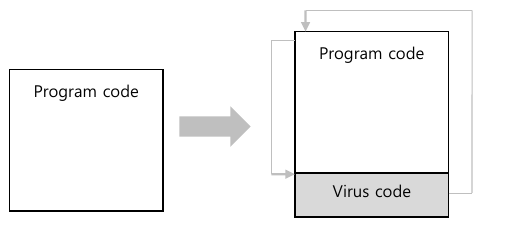
Fig. 1. The example of an infection by a prepending virus.